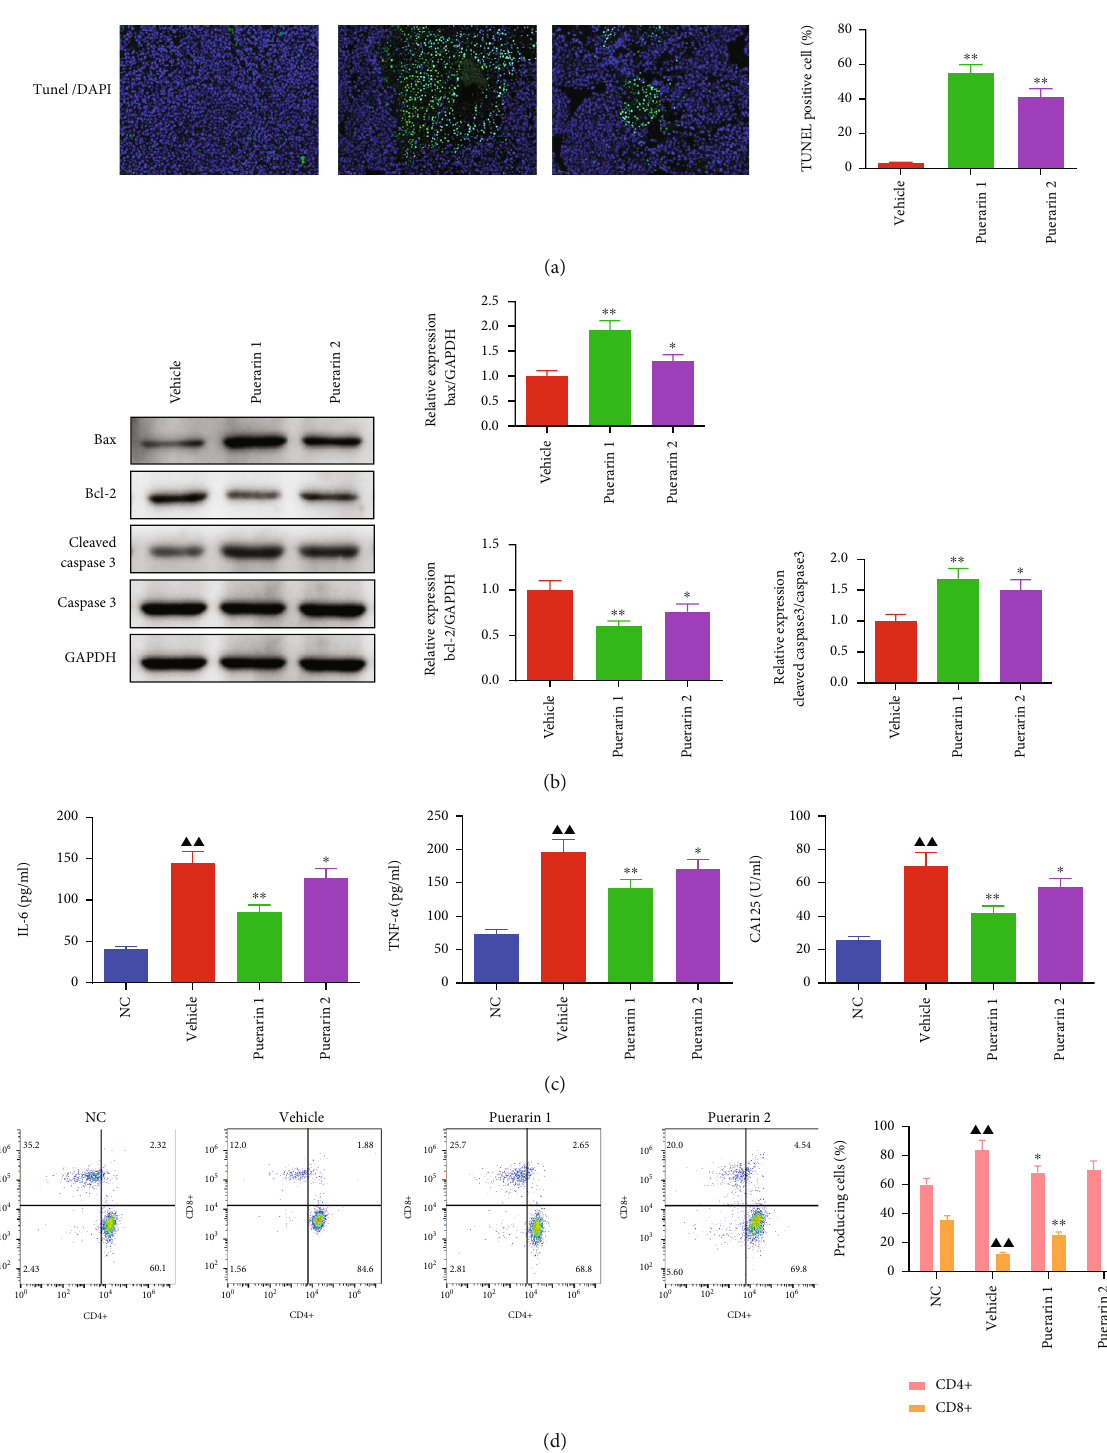
Figure 4: Puerarin treatment activates cell apoptosis and related proteins, while suppressing IL-6, TNF- α , and CA125 levels and modulating CD3+CD4+CD3+/CD8+ T lymphocyte percentages in OC tumor-bearing Fischer 344 rats. (a) TUNEL staining for the detection of cell apoptosis in OC tumor tissues (magni fi cation: × 200). (b) Protein expression levels of Bax, Bcl-2, cleaved caspase 3, and caspase 3 in tumor tissues were detected by Western blot assay, and GAPDH was used as the internal control. (c) Serum levels of IL-6, TNF- α , and CA125 were detected by ELISA. (d) Flow cytometry was used to detect the CD3+CD4+CD3+/CD8+ T lymphocyte percentages. The data are presented as mean ± SD . ▲▲ p < 0 : 01 , compared to the NC group; ∗ p < 0 : 05 , ∗∗ p < 0 : 01 , compared to the vehicle group. OC: ovarian